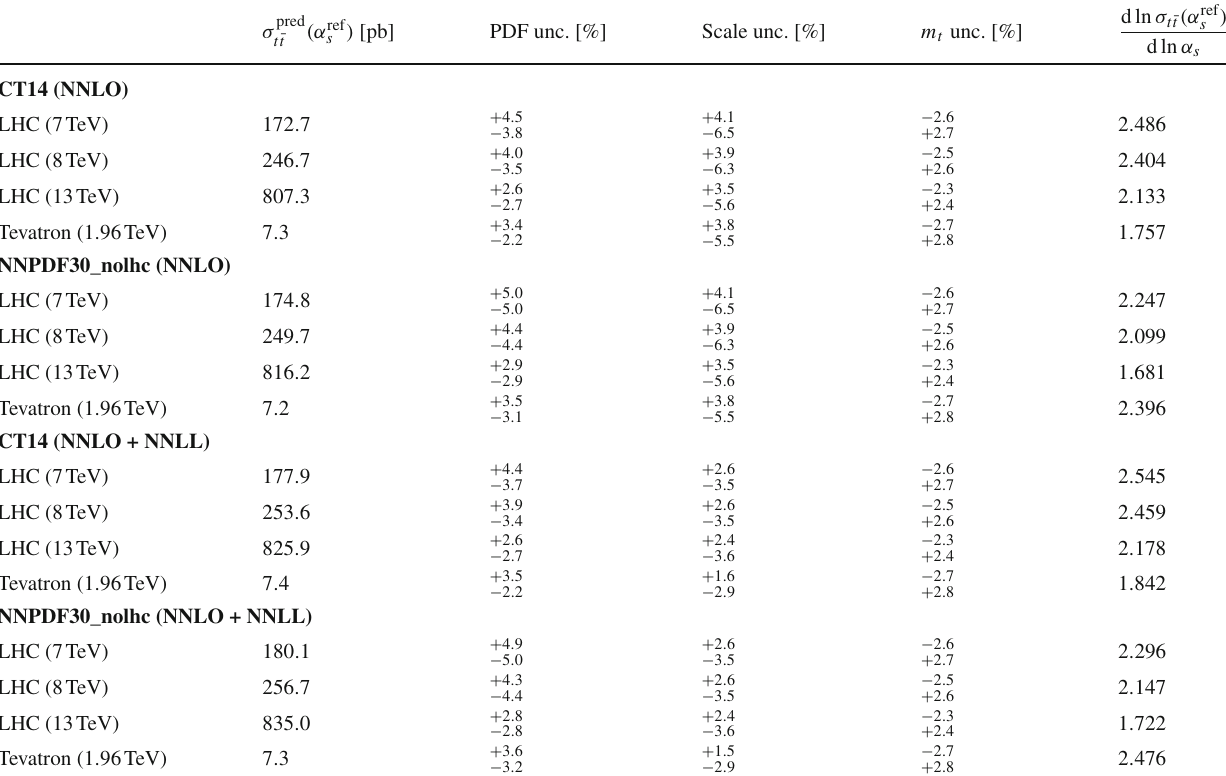
Table 3 Predicted cross sections and uncertainties for the PDF sets that we use [34,36], as determined with the Top++ program [23] at a reference value of α ref s = 0 . 118. The results are for m t = 173 . 2GeV